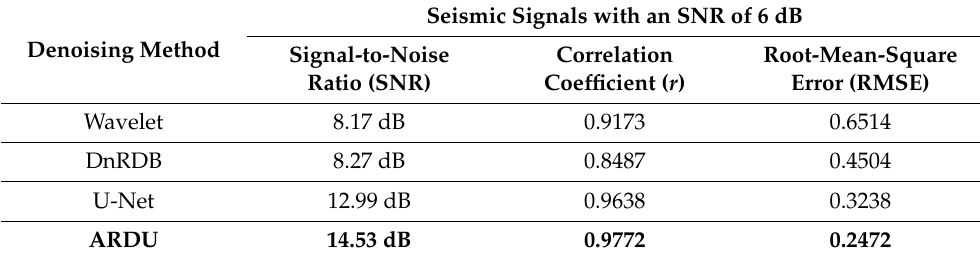
Table 3. Denoising results of seismic signals with an SNR of 6 dB using different methods.